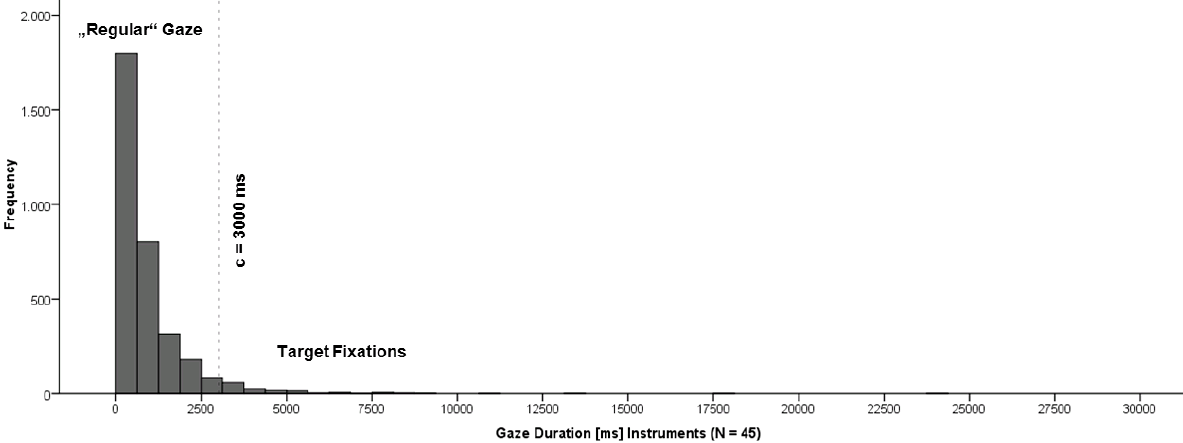
Figure 5. Frequency Distribution of Gaze Duration for Instruments (c = 3000 ms, see EASA,